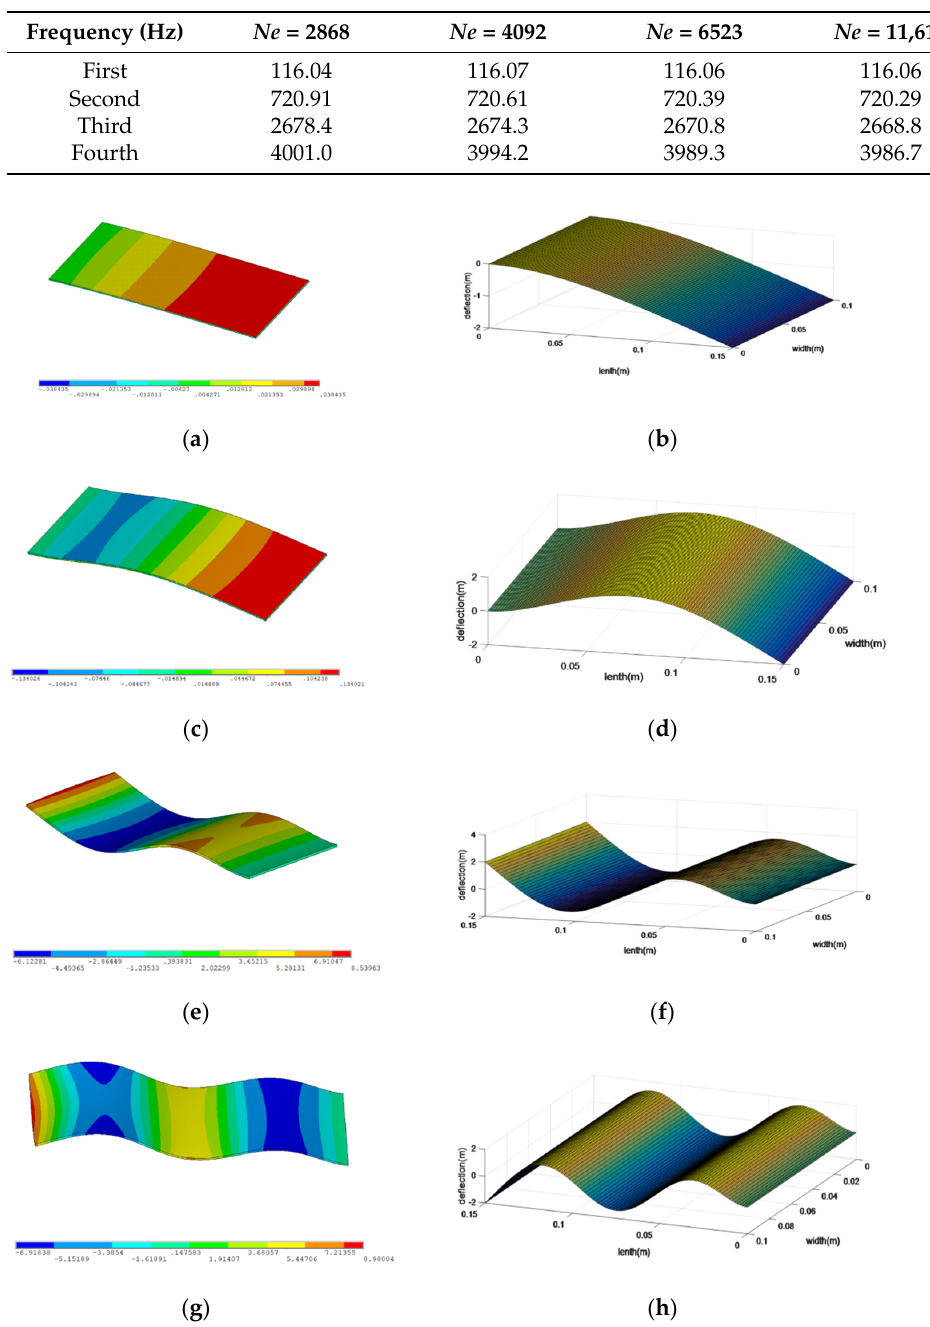
Table 6. Comparison between theoretical and finite element results. Table 5. Frequencies with different finite element numbers.